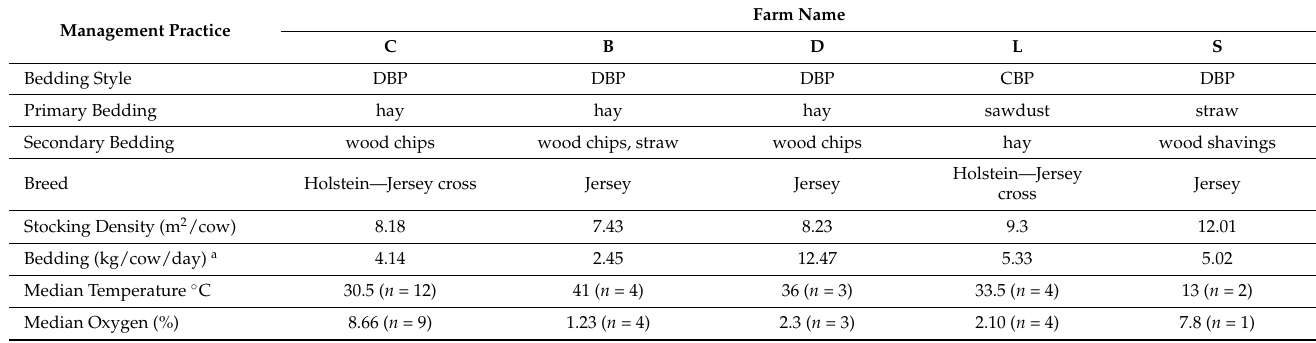
Table 1. Bedding material, stocking density and median temperature and oxygen for each farm. Wood shavings were dried compressed pine, sawdust was freshly milled pine. Wood chips were unidentified type, except Farm C used hardwood chips. Hay was farm-grown. Straw was purchased (Farm S) or farm-grown (B). Primary bedding represents approximately 75% of bedding, whereas secondary bedding represents 25%. Bedding style is either deep bedded pack (DBP) or compost bedded pack (CBP). More management details for each farm are available in Table